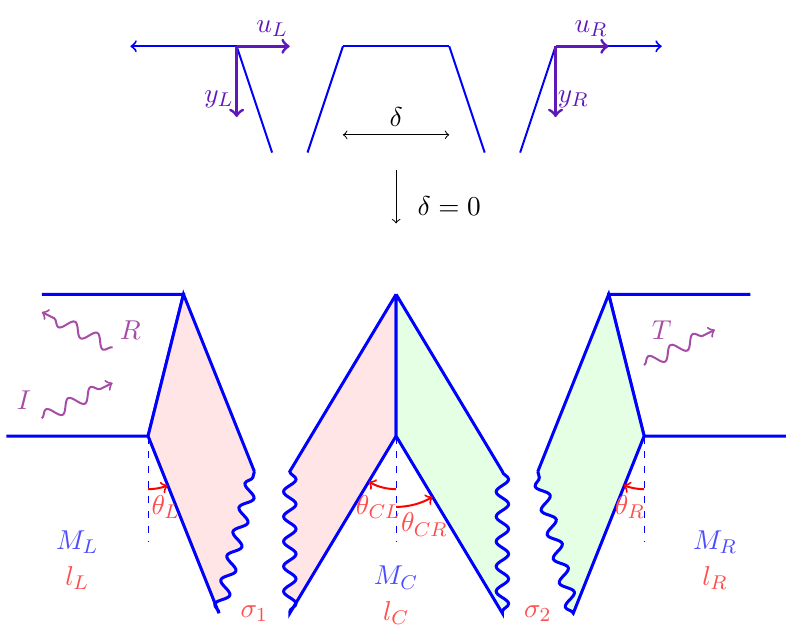
Figure 1 . The 3 region holographic model representing the fusion of two defects. I is the gravitational wave scattered from the left, and R and T are the reflected and transmitted waves on the left and right of the interface